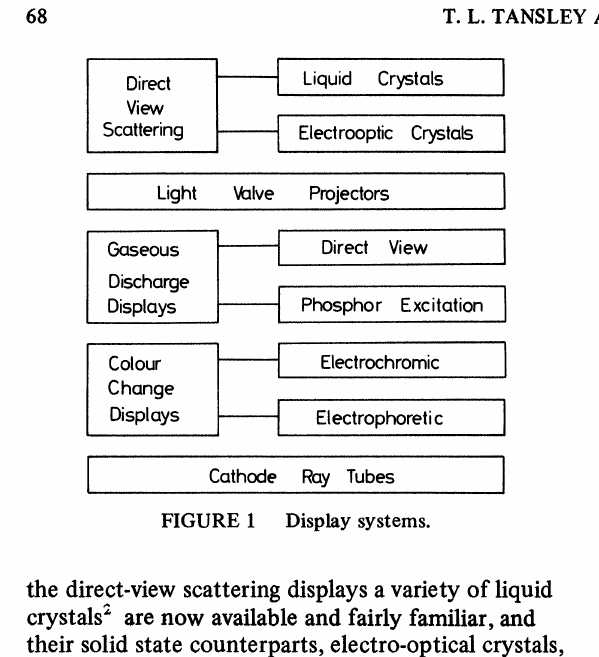
FIGURE Display systems.